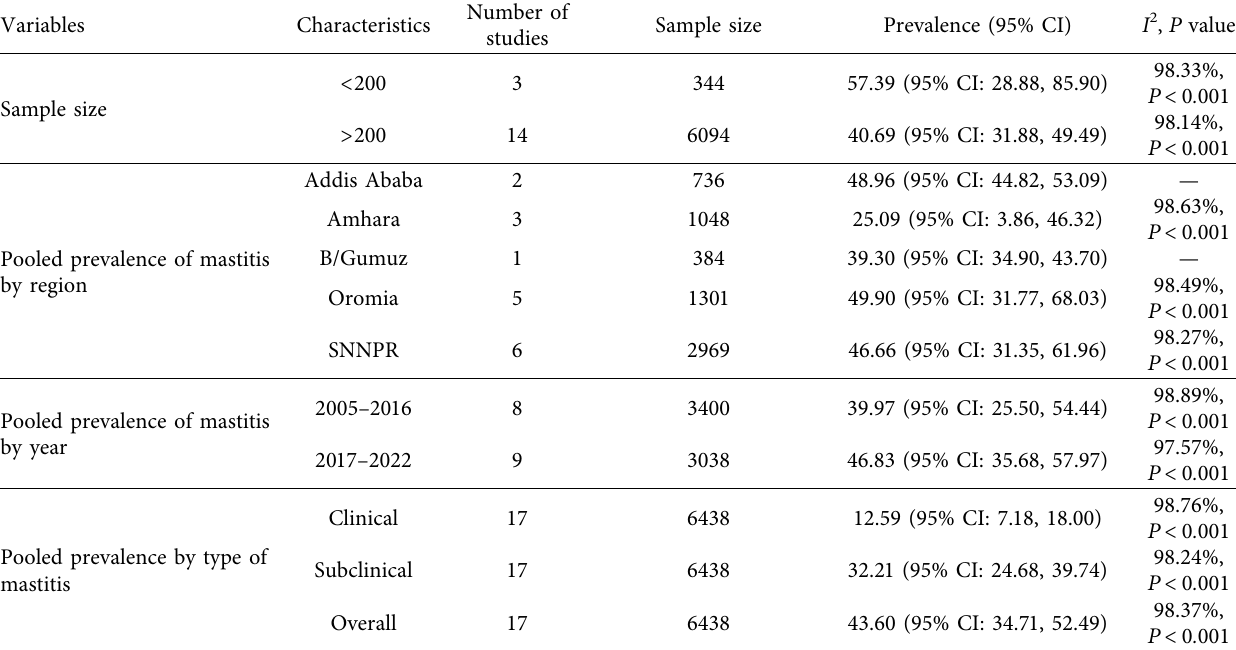
Table 3: Prevalence of bovine mastitis among dairy cows in Ethiopia by subgroup analysis.